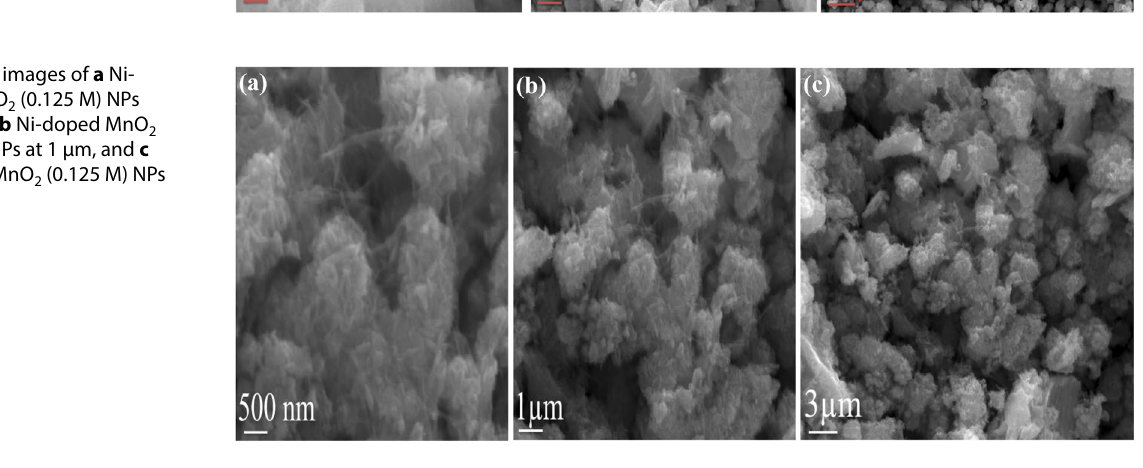
Fig. 6 SEM images of a Ni- doped MnO (0.125 M) NPs 2 at 500 nm, b Ni-doped MnO 2 (0.125 M) NPs at 1 µm, and c Ni-doped MnO